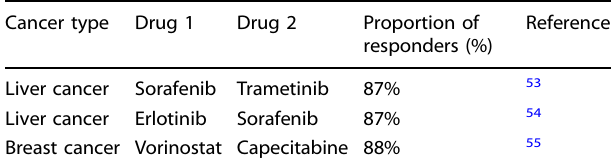
Table 2. Examples of predicted combination